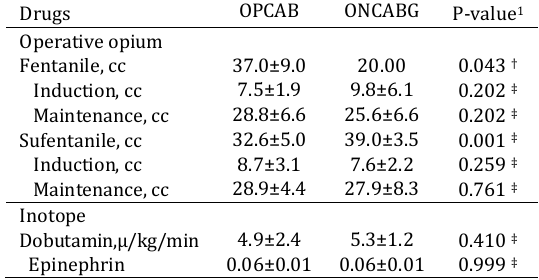
Table 2. Comparison of Operative opium and Inotrop usage between OPCAB and ONCAB group. Drugs